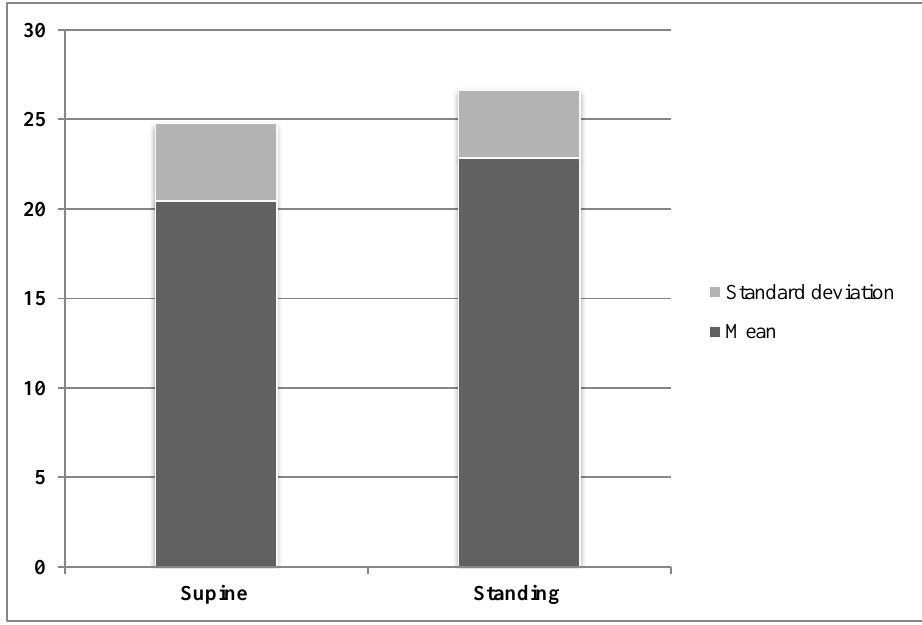
Figure 3. Mean and SD of Q angle measurement in supine and standing